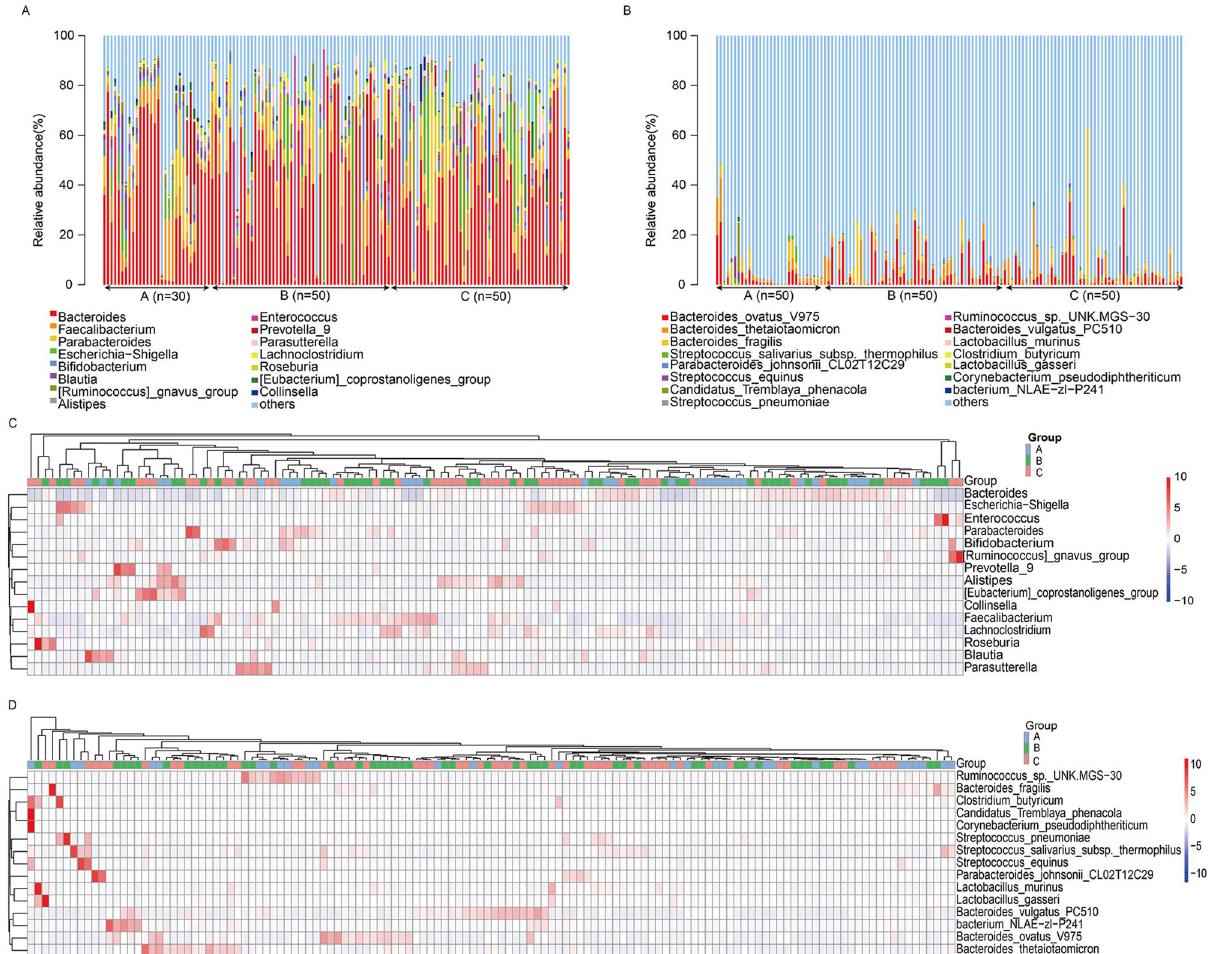
Figure 1. Microbiota profiles in healthy and MPP child. Top 15 abundant microbiota in healthy ( A , n = 30), nonwheezing MPP ( B , n = 50), and wheezing MPP ( C , n = 50) child at the (a) genus and (b) species levels. Heatmap of top 15 abundant microbiota in healthy child ( A , n = 30), child with nonwheezing MPP ( B , n = 50), and child with wheezing MPP ( C , n = 50) at the (c) genus and (d) species